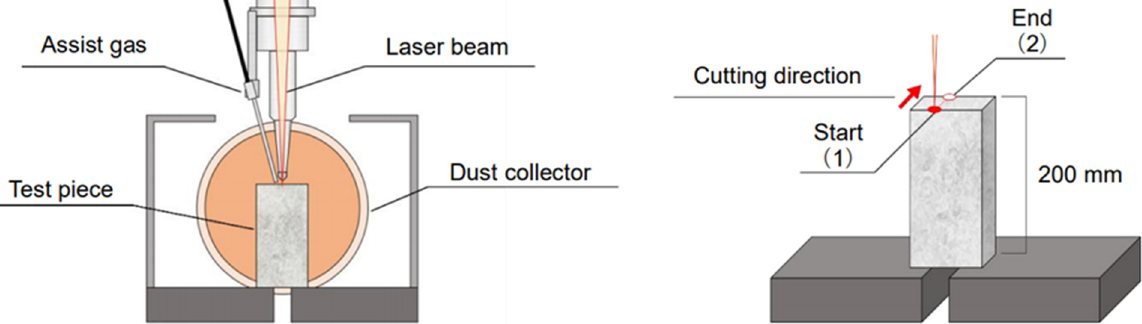
Figure 1. Schematic of laser irradiation.